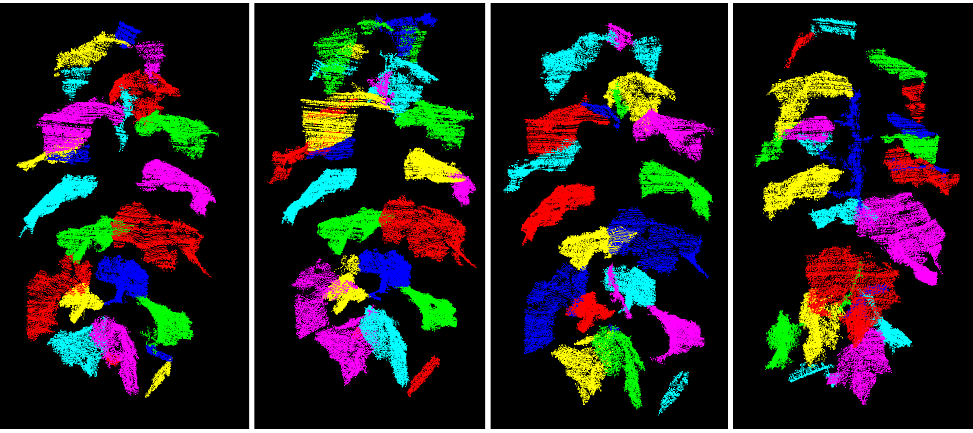
Figure 12. Result of the spatial segmentation of plant p 1_ l